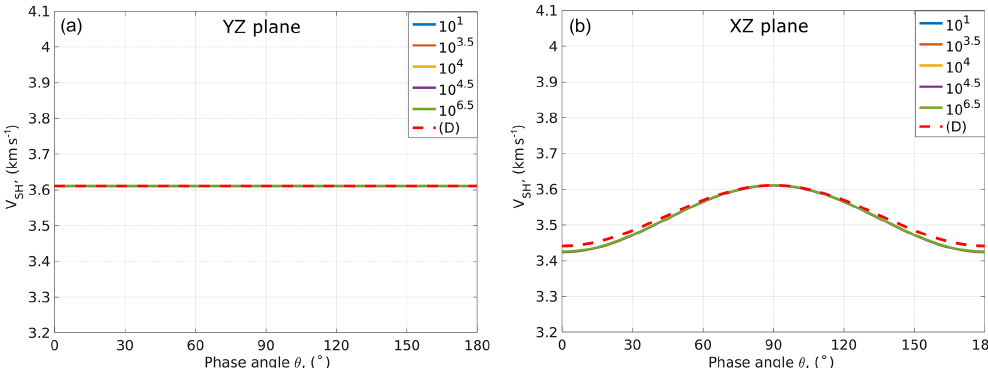
Figure 7. SH-wave phase velocity versus phase angle in the Y – Z plane (a) and the X – Z plane (b) . Curves 10 1 − 10 6 . 5 denote the frequency of the P wave for the model with connected cracks. (D) denotes the P wave for the model with disconnected